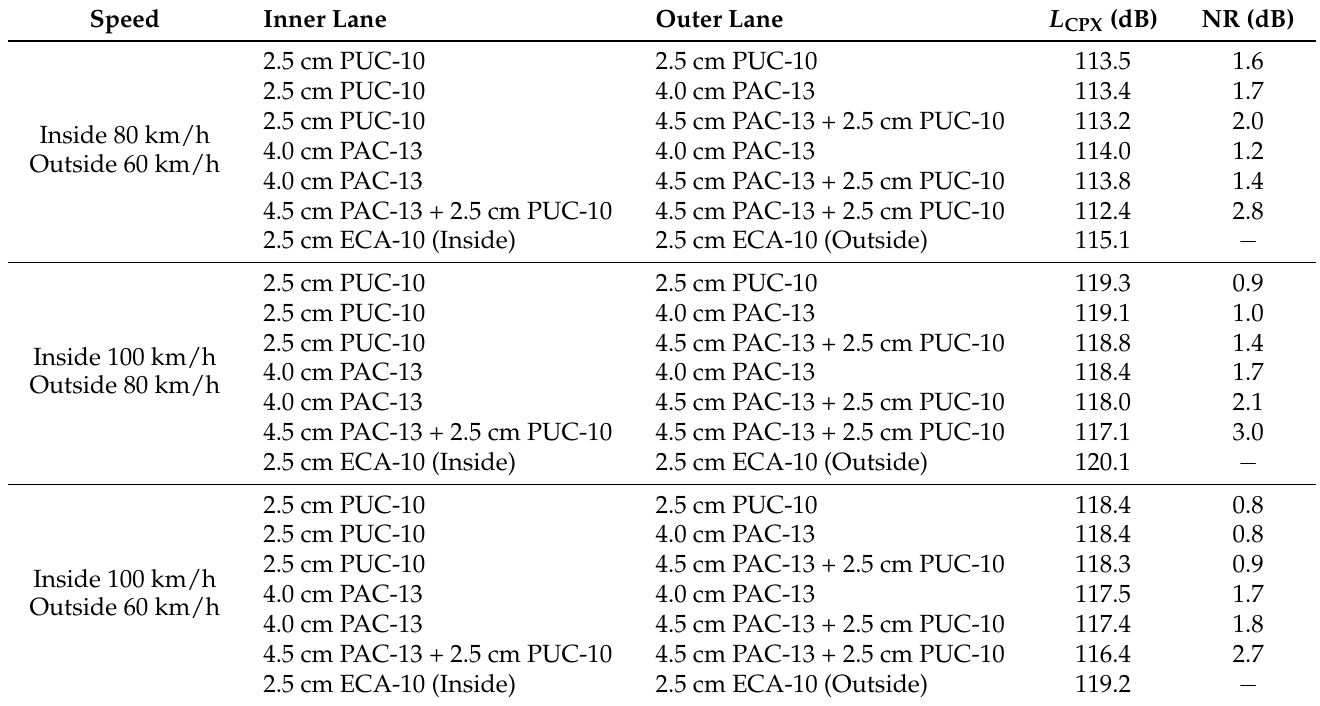
Table 4. L CPX of composite pavement at different speeds in two nearby